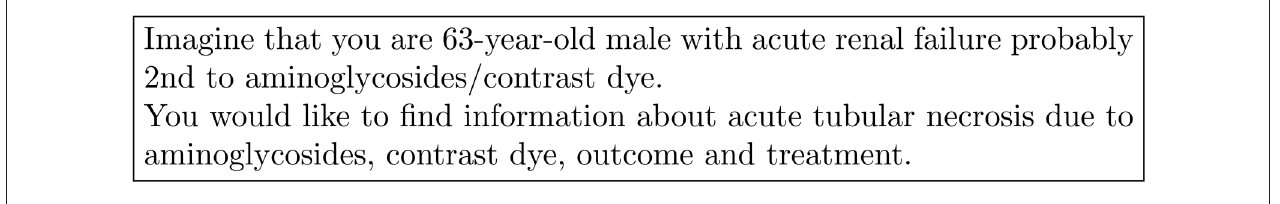
FIGURE 2 | An example OHSUMED search topic, reworded for the participants.